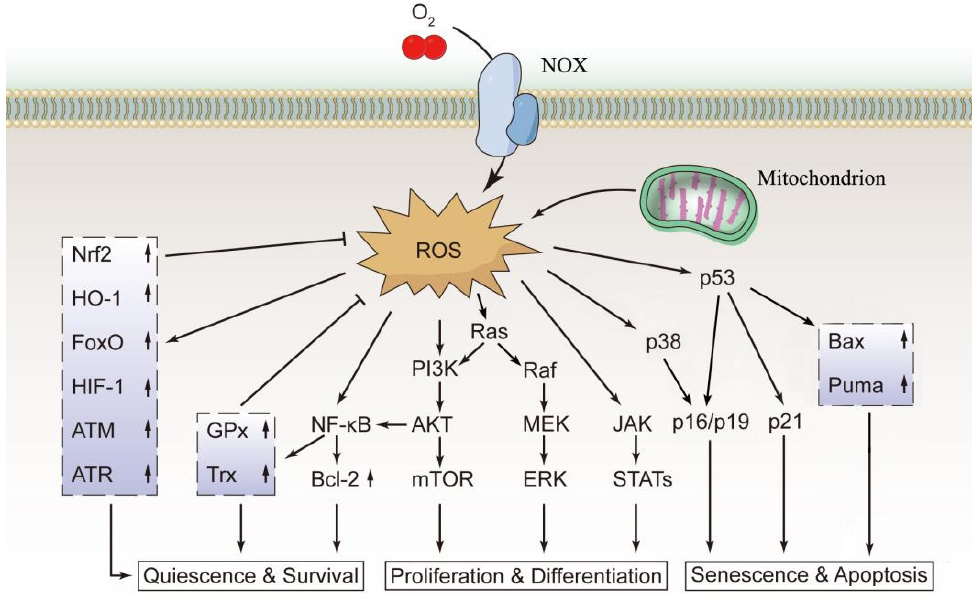
Figure 1. The main redox signaling pathways in normal HSCs. The biological functions of normal HSCs are closely regulated by ROS. ROS can activate the PI3K, MEK, and JAK signaling pathways to promote cell proliferation and differentiation. Excessively high ROS levels activate the p38 or p53 signaling pathway, leading to cell senescence and apoptosis. Additionally, ROS upregulate the expression of Nrf2 and HO-1, which block excessive ROS production through feedback inhibition, thus maintaining intracellular ROS at a normal level to maintain the quiescent state and normal function of the cells. This figure was drawn based on existing research data; its accuracy and more precise signaling mechanisms must be confirmed and supplemented by extensive, in-depth studies.